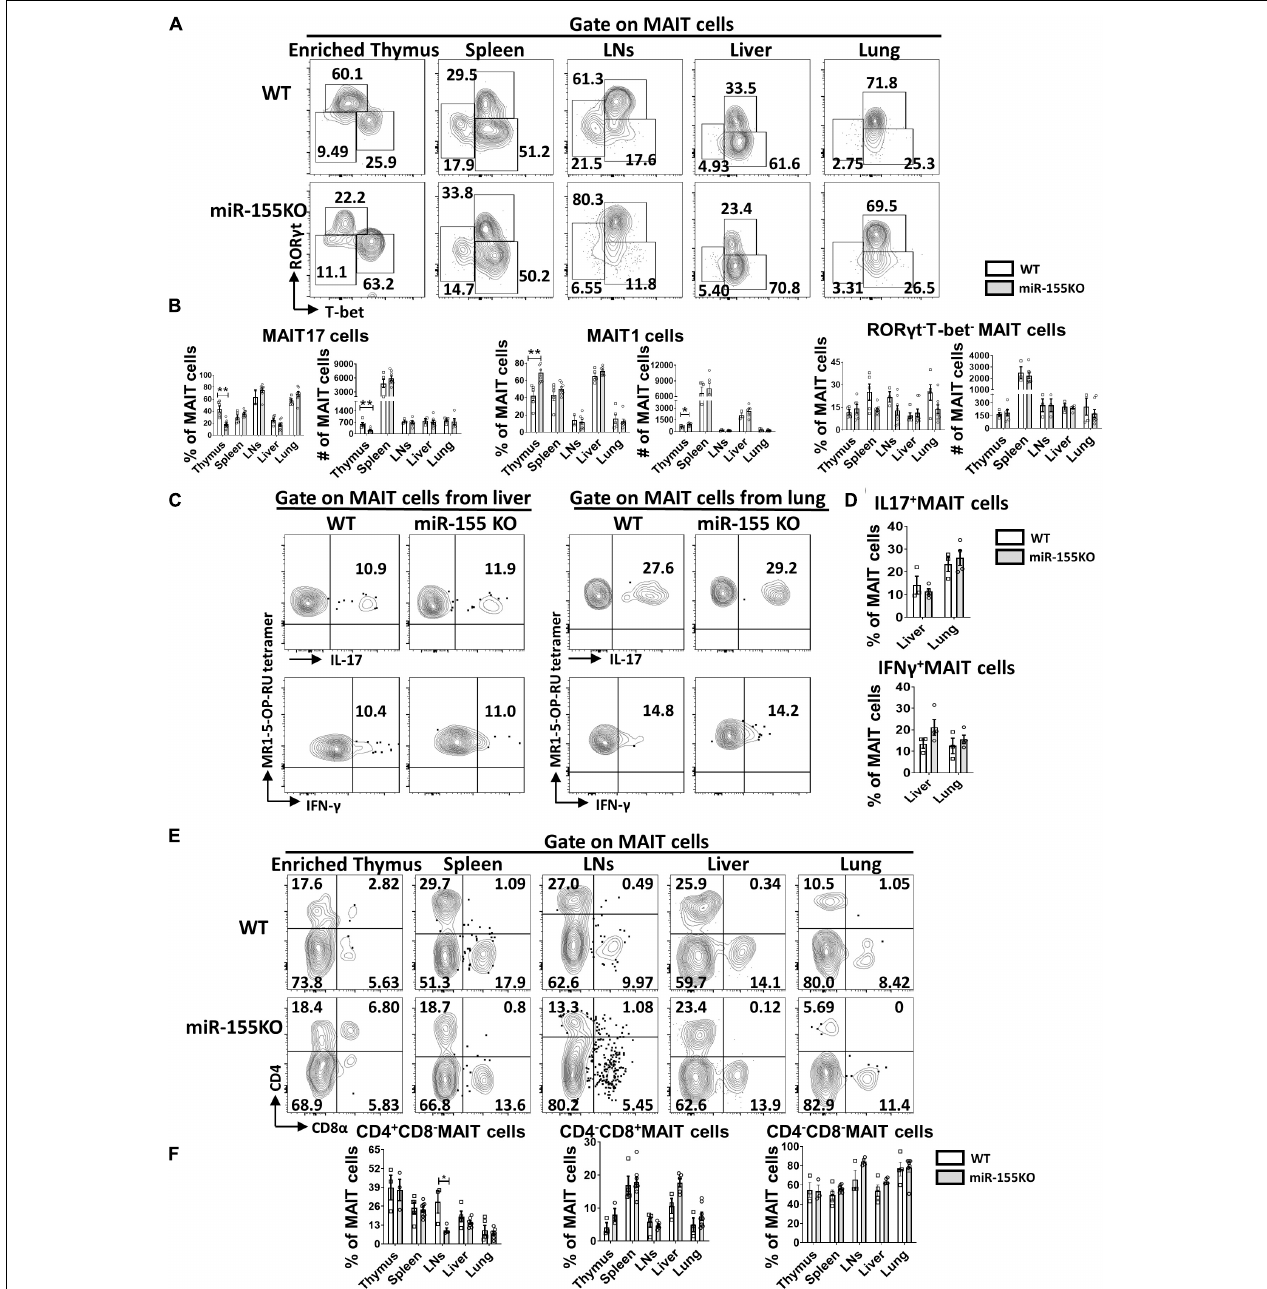
FIGURE 7 | Differentiation and function of MAIT cells were unaffected substantially by the absence of miR-155. (A) Flow cytometric analysis of intracellular ROR γ t and T-bet expression in MAIT cells from thymus, spleen, LNs, liver, and lung in WT and miR-155KO mice. Numbers adjacent to outlined areas indicate percentage of indicated populations. (B) The percentages and absolute numbers of MAIT 17, MAIT1, ROR γ t − Tbet − subsets in thymus and peripheral organs. (C) IL-17 and IFN- γ production of MAIT cells from liver and lung in miR-155 KO mice. (D) Percentage of IL-17 and IFN- γ in liver and lung. (E) Flow cytometry analysis of CD4 and CD8 coreceptor expression on MAIT cells in thymus, spleen, LNs, liver, and lung from WT and miR-155KO mice. (F) Percentage of MAIT cells subsets that express CD4, CD8, or neither coreceptor in the indicated organs. Data are from at least three independent experiments. Each mouse is represented as one dot. 3–8 mice for each group. Data were analyzed by unpaired t -test. * p < 0.05, ** p < 0.01 compared with WT controls.